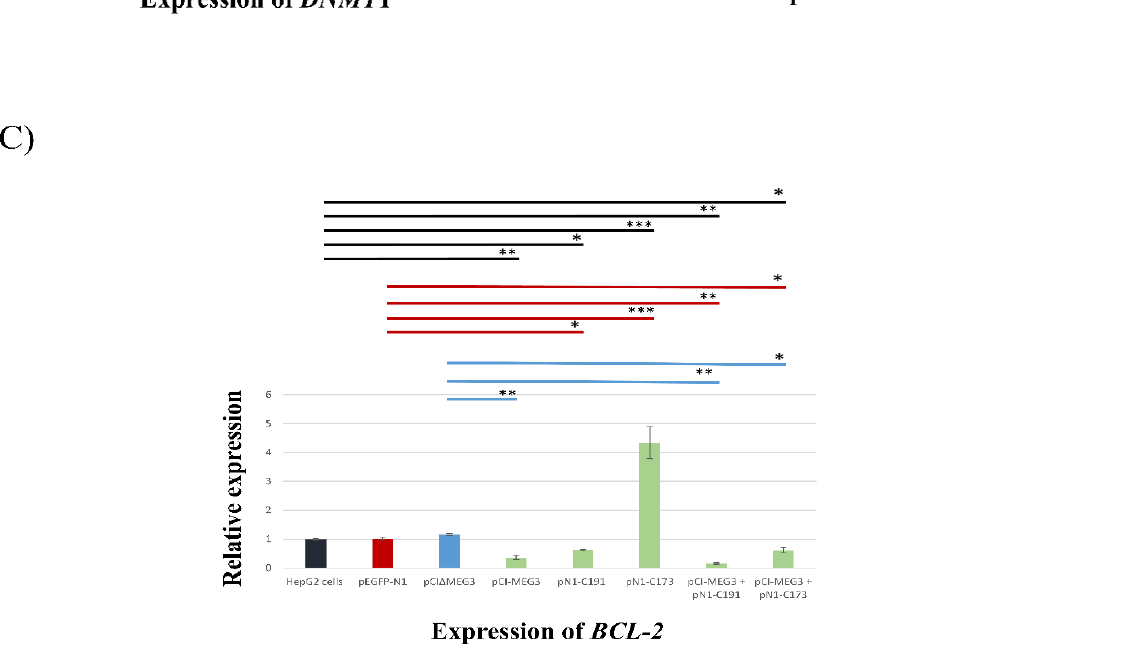
Figure 5. Quantification of the changes in expression of different cellular genes by qRT-PCR after transfection of HepG2 cells by different plasmids; pEGFP-N1, pCI ∆ MEG3, pCI-MEG3, pN1-C191, pN1-C173, pCI-MEG3 + pN1-C191, and pCI-MEG3 + pN1-C173 compared to control untransfected HepG2 cells. The mean of three independent replicates was used to calculate these data values. Data presented as mean ± SD. ( A ) respresnts the relative expression change of P53 and miRNA152. ( B ) respresnts the relative expression change of DNMT1 and TGF-b. ( C ) respresnts the relative expres- sion change of BCL-2. (*) represents p -value < 0.05, (**) represents p -value < 0.01, and (***) represents p -value < 0.001 compared to control untransfected HepG2 cell, pEGFP-N1, and pCI ∆ MEG3. Colored lines represent the significance of gene expression between each sample and its control. Controls are divided into (a) HepG2 cells (Black), (b) HepG2 cells transfected with pEGFP-N1 (Red), and (c) HepG2 cells transfected with pCI ∆ MEG3 (Blue).